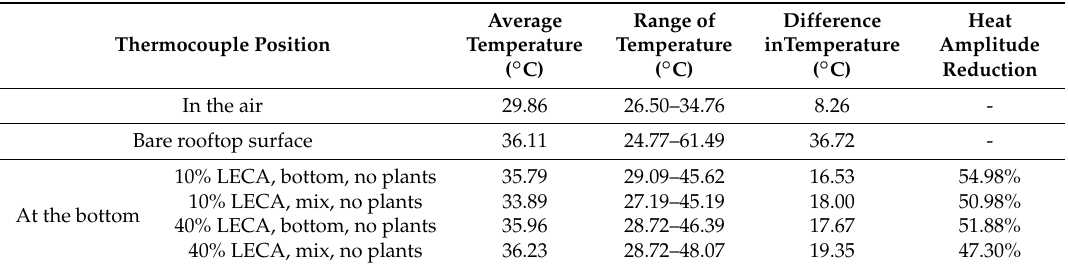
Table 10. Reduction in the heat amplitude in the cases of the roofs with 10% and 40% LECA laid at the bottom without plants, and of 10% and 40% LECA mixed with the soil without plants (24